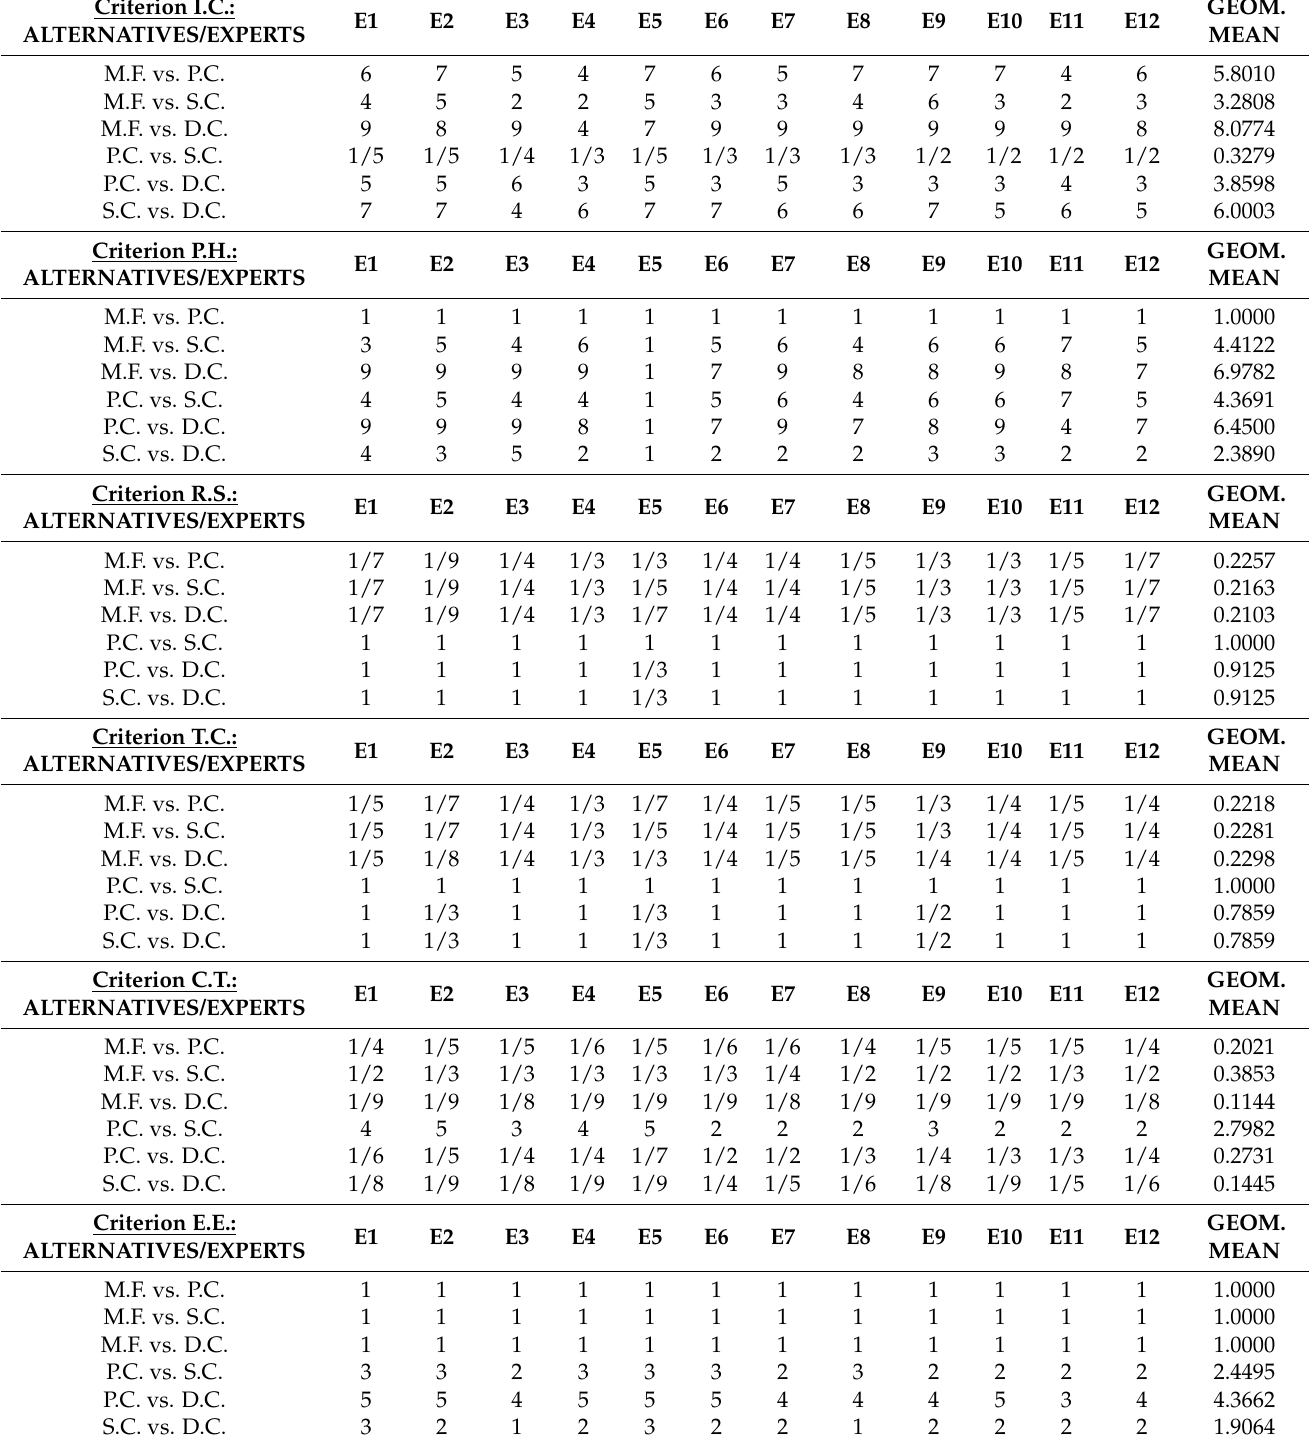
Table 9. Expert judgments and geometric mean for the alternatives pair-wise comparison, with regard to each criterion. Criterion